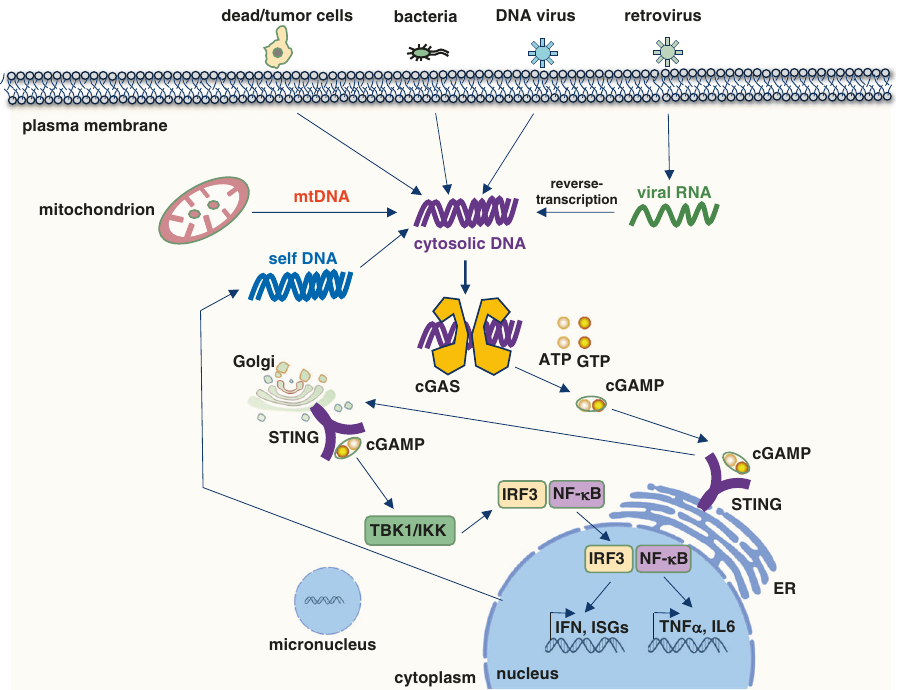
Fig. 2 The cGAS – STING signaling pathway senses cytosolic DNA derived from either viral/bacterial infection or self-DNA. DNA is a pathogen-associated molecular pattern when delivered to the host cytoplasm by viral or microbial infection, and a danger-associated molecular pattern when leaked into the cytoplasm from damaged mitochondria or nucleus. cGAS is the cytosolic DNA sensor that recognizes and binds cytosolic DNA in a DNA-sequence-independent manner that subsequently triggers cGAS dimerization and production of a special dinucleotide messenger, 2 ′ 3 ′ -cGAMP from ATP and GTP. 2 ′ 3 ′ -cGAMP binds STING localized on ER, through traf fi cking to Golgi to recruit and activate IKK and TBK1. TBK1 phosphorylates STING, which in turn recruits IRF3 for phosphorylation by TBK1. Phosphorylated IRF3